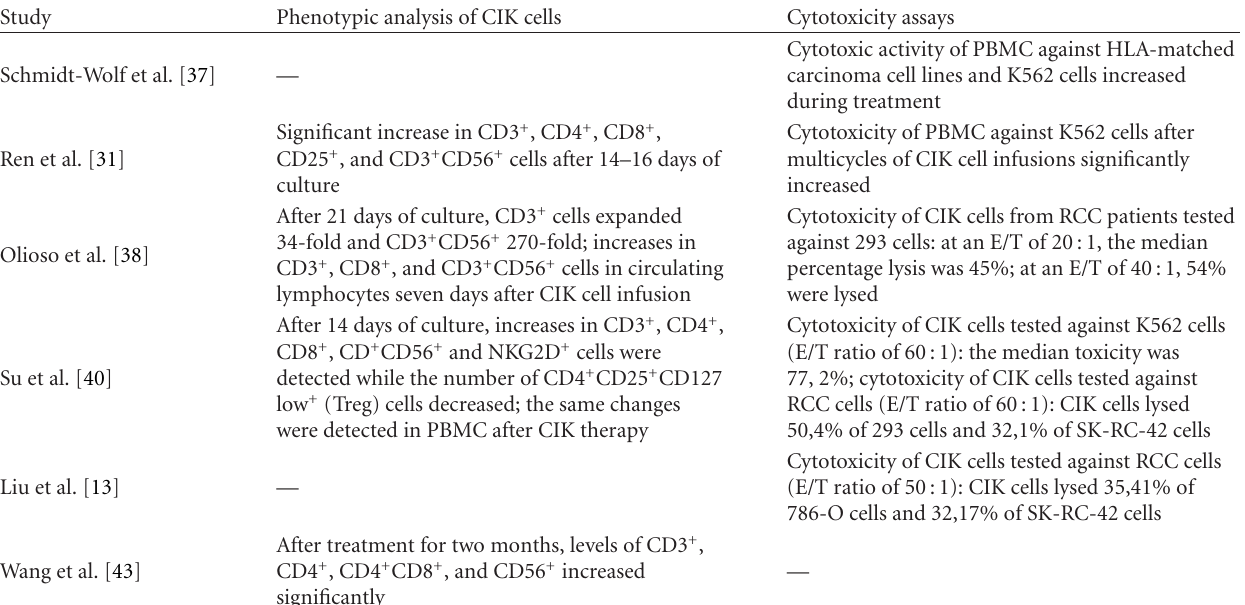
Table 1: Summary of in vitro assays conducted with CIK cells of study